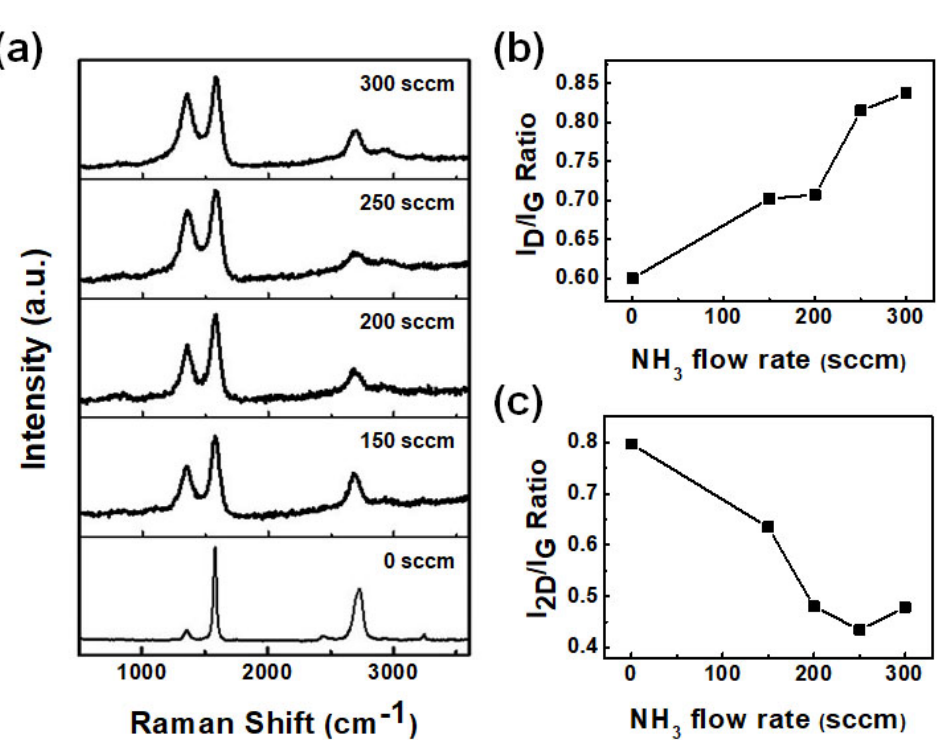
Figure 3. ( a ) Raman peaks of the synthesized nitrogen-doped Ni-graphene CSNPs with different NH 3 flow amounts, ( b ) the intensity ratio of the D- and G-bands, I D /I G , and ( c ) the intensity ratio of the 2D- and G-bands, I 2D /I G .